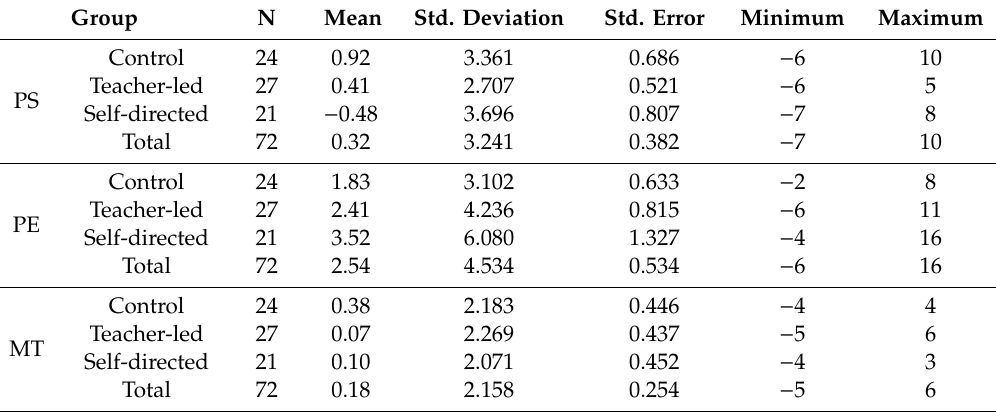
Table 3. Metacognitive awareness development on the MALQ